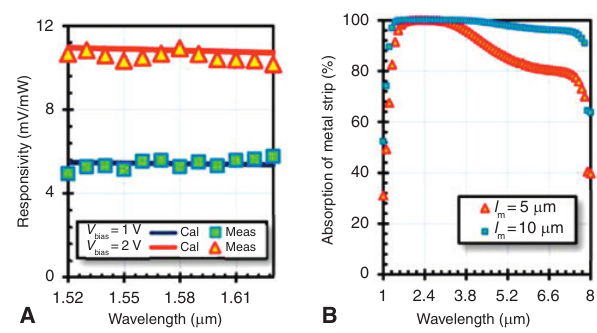
= 15 μ m when V = 1 and 2 V. (B) m bias = 400 m